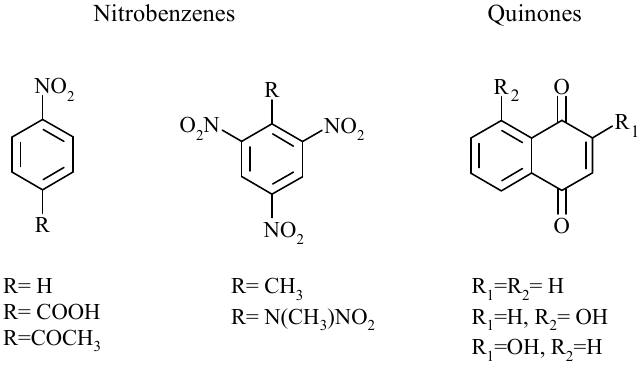
Figure 1. Formulae of oxidants studied in this work.